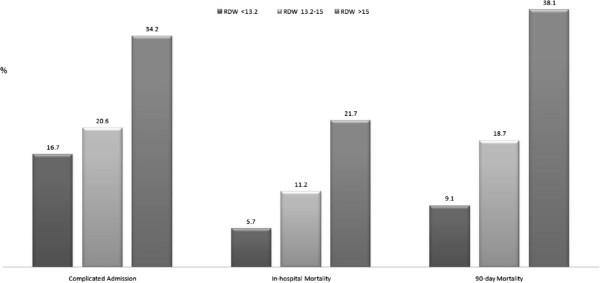
Complicated admission, in-hospital mortality and 90-day mortality association with elevated RDW.